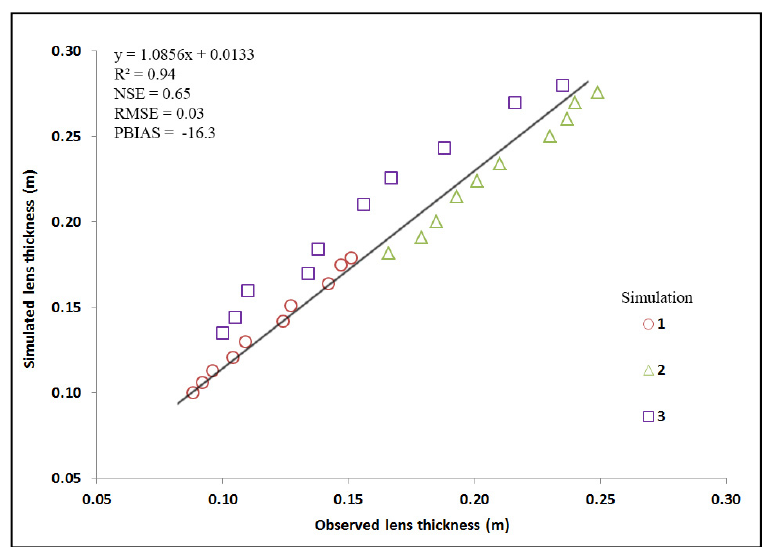
Figure 8. Simulated vs. observed IFL thicknesses.